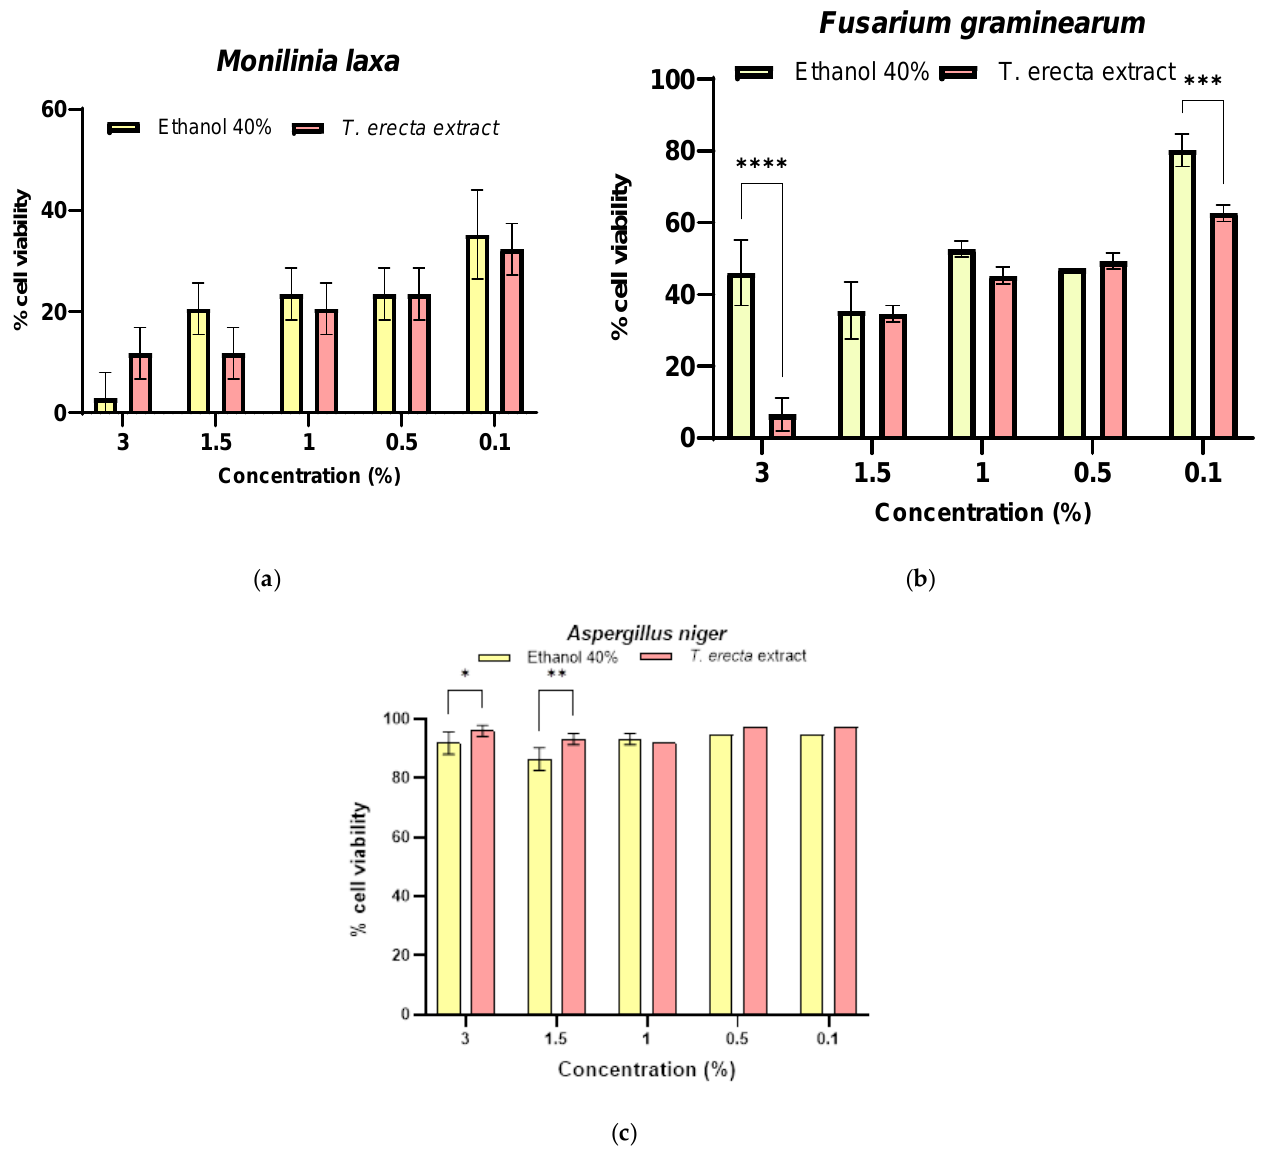
Figure 5. Quantitative antifungal activity of T. erecta extract compared to that obtained for solvent on the M. laxa ( a ), F. graminearum ( b ), and A. niger ( c ) strains, where * p < 0.05, ** p < 0.01, *** p < 0.001, **** p < 0.0001.